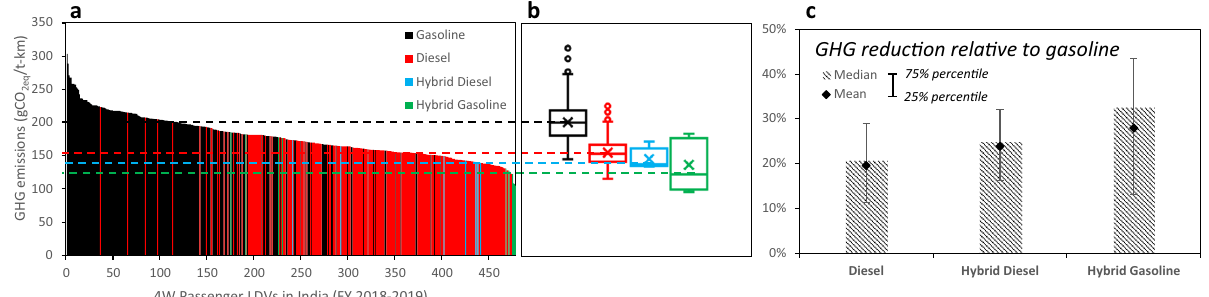
Fig. 5 GHG emissions intensity of four-wheeled (4 W) passenger road light-duty vehicles (LDVs) in India in 2018/19. ( a ) Life cycle GHG emissions range for 478 passenger road vehicles in India in gCO 2eq /ton-km. ( b ) Interquartile GHG emission ranges for gasoline SI, diesel CI, diesel-electric hybrids, and gasoline-electric hybrids. The box-and-whisker plots show the median line, mean marker, 25th / 75th percentile box, min/max whiskers, and potential outliers. ( c ) GHG emission reduction relative to gasoline SI